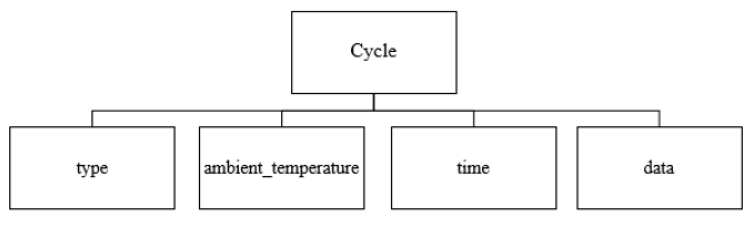
Figure 7. Data structure.